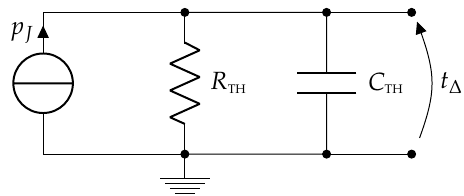
Figure 6. Simplified thermal network of an electric